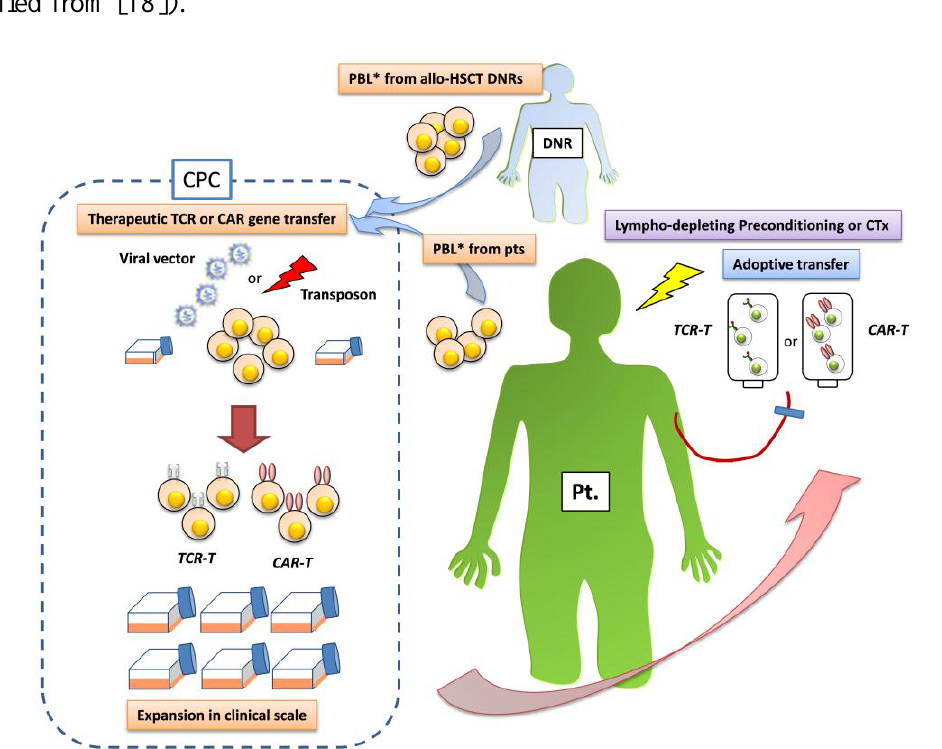
Figure 1. Flow chart of antileukemia adoptive immunotherapy using gene-modified T cells (modified from